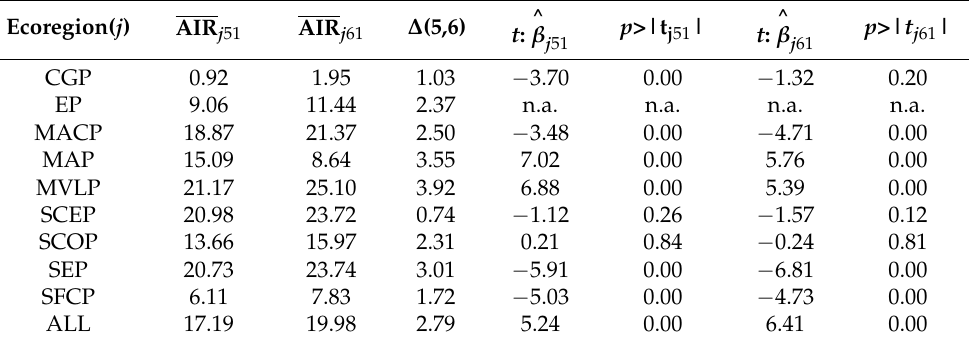
Table 5. Means of the airborne lidar percentiles at the 95th ( k = 6 ) and 90th ( k = 5 ) percentiles and their differences, Δ(5,6); t -values, and associated probabilities of greater t ’s under the hypothesis that the slopes are equal to one. Ecoregion( j )